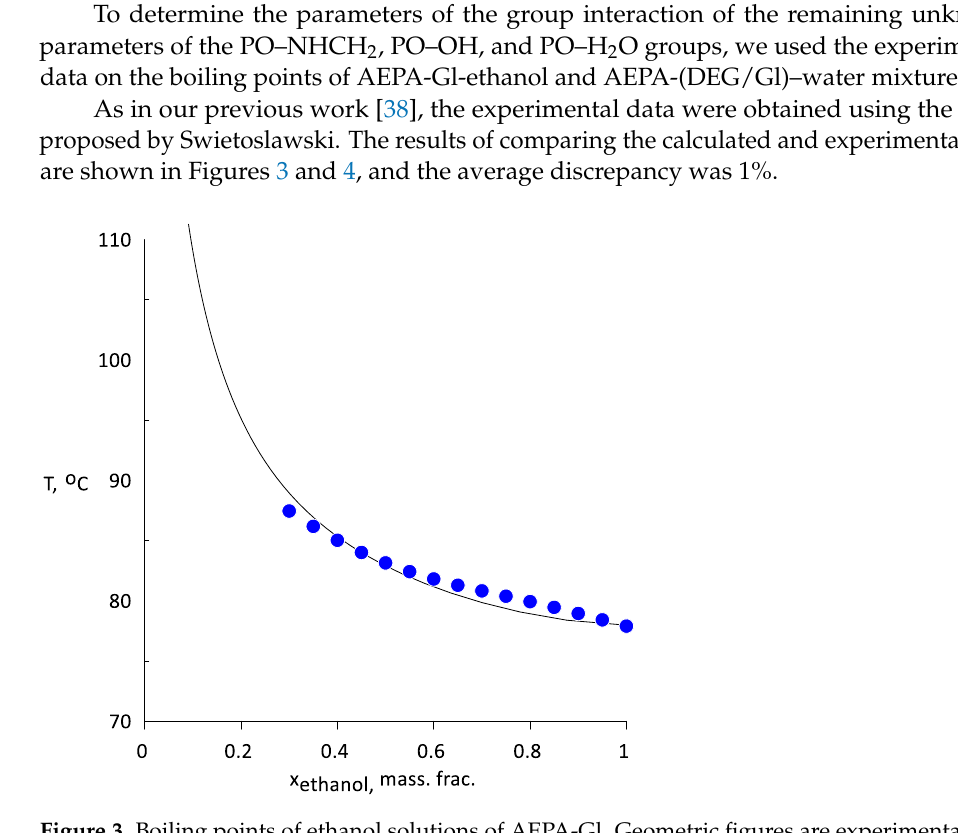
Figure 3. Boiling points of ethanol solutions of AEPA-Gl. Geometric figures are experimental data, continuous line is calculated data.